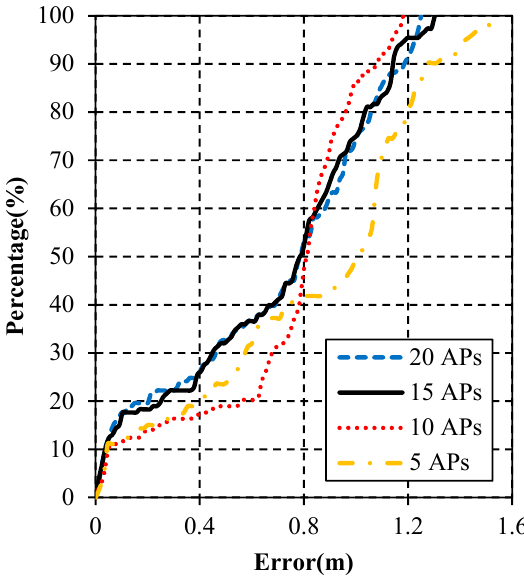
Figure 13. Cumulative error percentages using different numbers of APs.